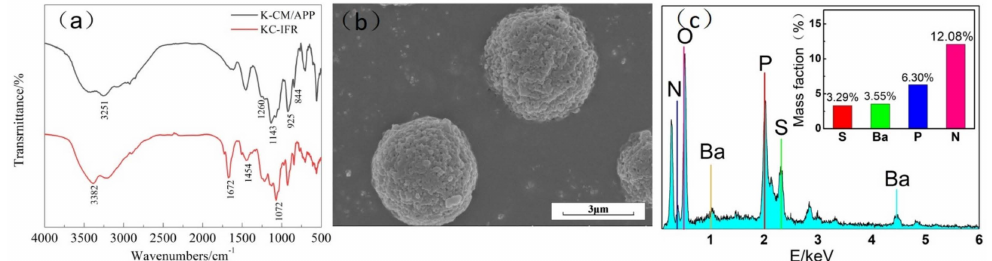
Figure 2. ( a ) Fourier transform infrared spectroscopy (FTIR) spectra of K-CM / APP and KC-IFR; ( b ) scanning electron microscopy (SEM) of KC-IFR; ( c ) energy dispersive X-ray spectroscopy (EDS) of